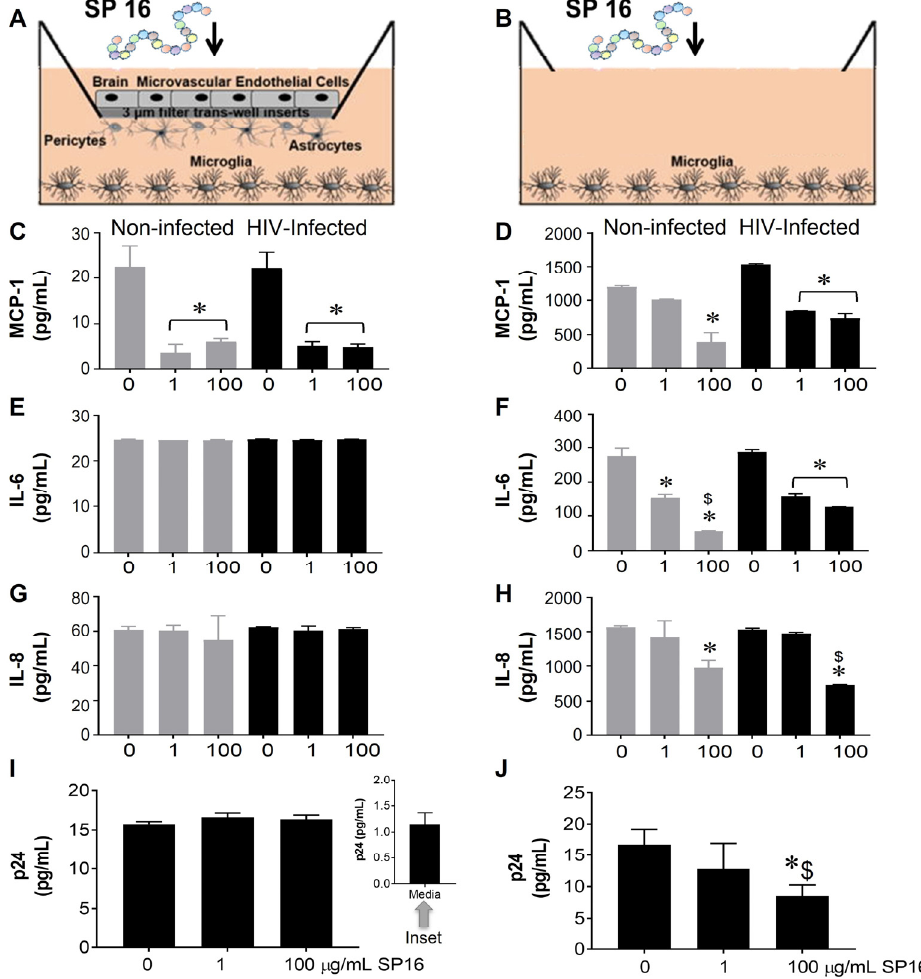
Figure 1. Anti-inflammatory and anti-viral responses of SP16 in microglia. SP16 at increasing concentrations was directly added to cells ( B , D , F , H , J ) or to the luminal surface of the BBB inserts ( A , C , E , G , I ). Supernatant was collected after 12 h and inflammatory molecules ( A – H ) and p24 ( I , J ) were measured by ELISA. Gray bars = non-infected cells, black bars = infected cells. Results are reported as the mean ± SEM of 3 independent experiments. Data were analyzed using one or two-way ANOVA analysis followed by Dunnett multiple comparisons. A value of p < 0.05 was considered significant. * vs. 0 SP16 (media); $ vs. 1 μ g/mL SP16.